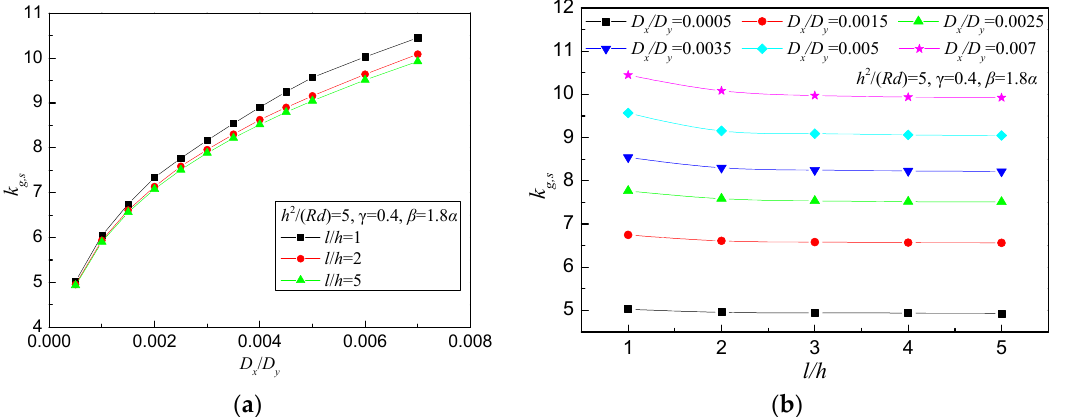
Figure 3. The effect of the rigidity ratio D x /D y and the length to height ratio l/h on the global shear Figure 3. The e ff ect of the rigidity ratio D x / D y and the length to height ratio l / h on the global shear buckling coefficient k g , s for the four-edge simple support: (a) D x /D y on k g , s ; (b) l/h on k g , s . buckling coe ffi cient k g , s for the four-edge simple support: ( a ) D x / D y on k g , s ; ( b ) l / h on k g , s .